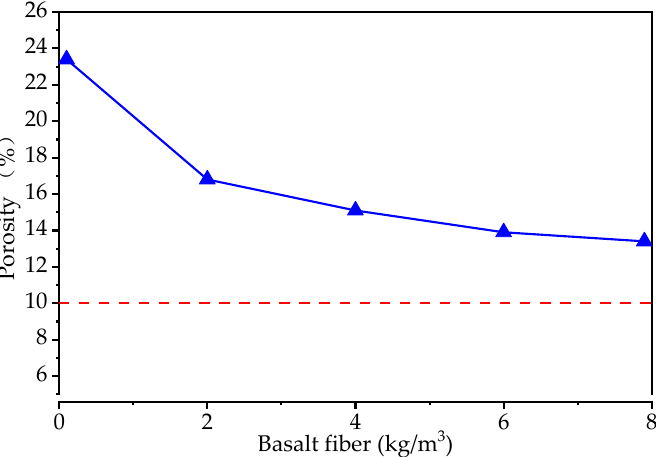
Figure 10. The testing of porosity.